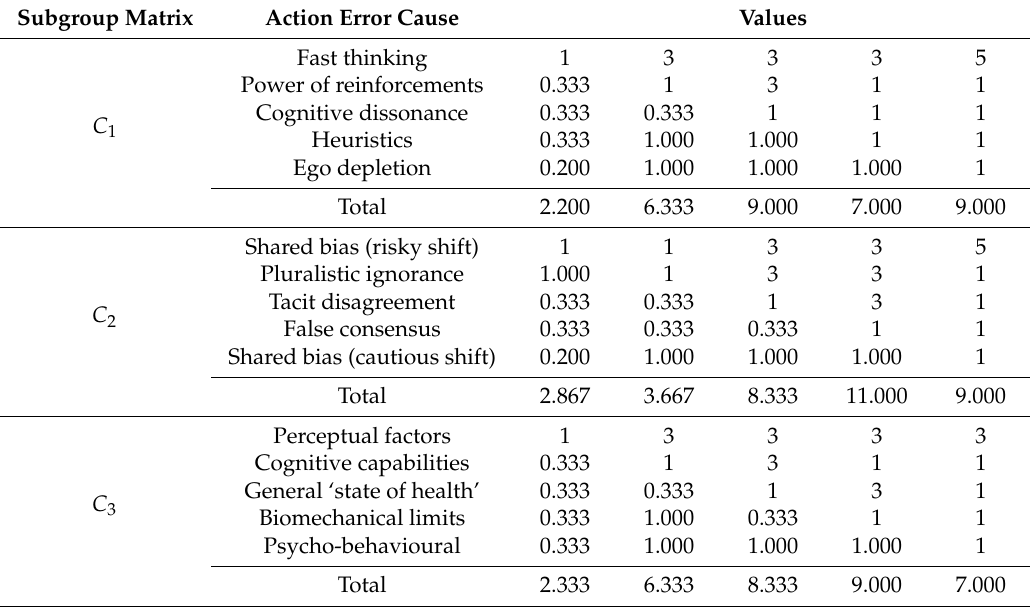
Table 5. Case study: Pairwise correlation of submatrices.